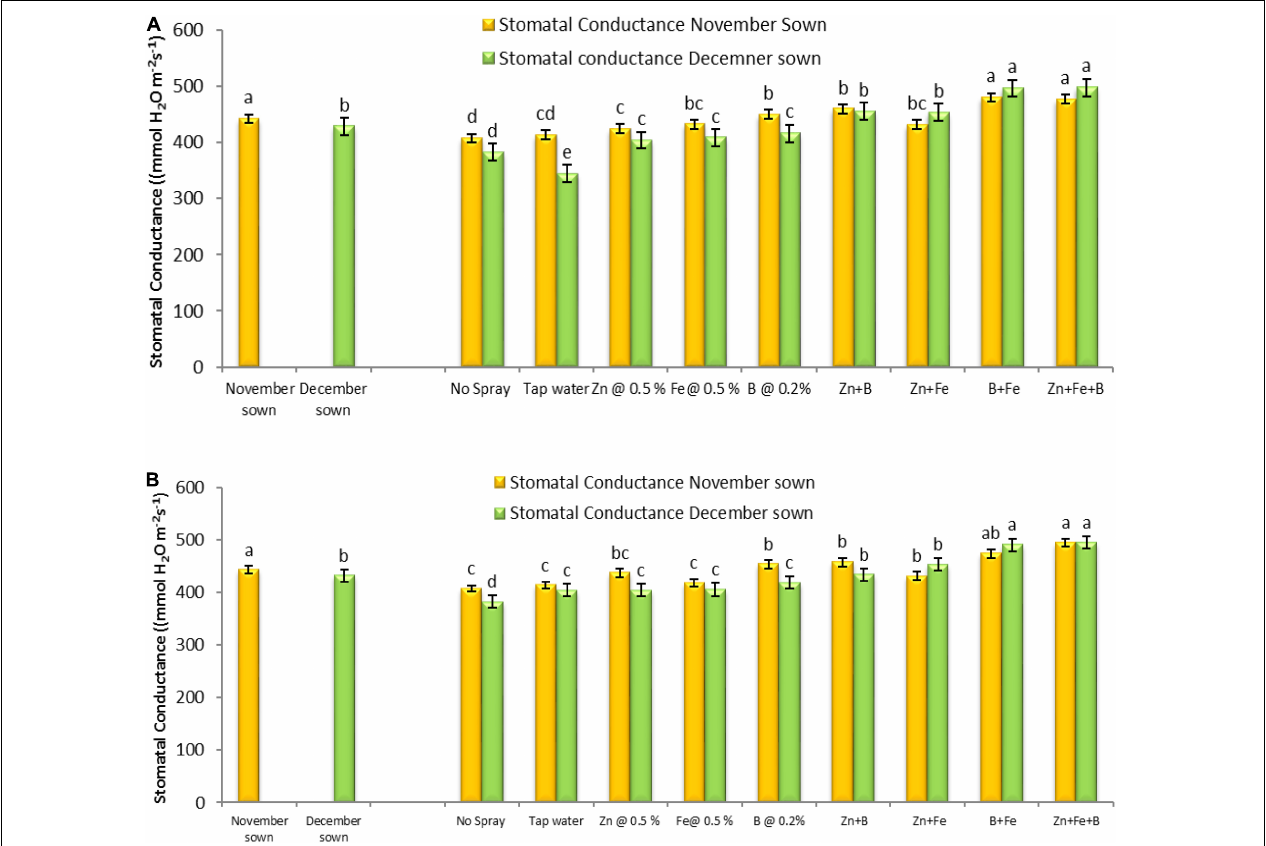
FIGURE 6 | Stomatal conductance ( µ mol CO 2 m - 2 s - 1 ) for different sowing dates and foliar spray treatments in the (A) 2018–19 and (B) 2019–20 lentil cropping seasons. Values are means, and bars represent ± SEM ( n = 3). Different letters indicate significant differences between means.